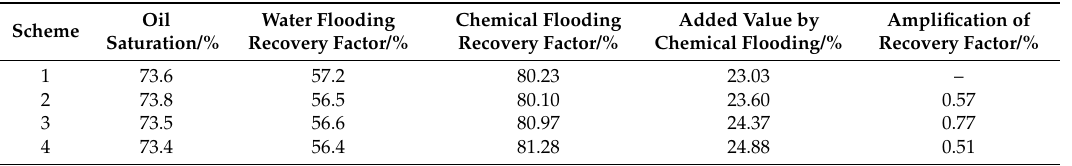
Table 9. Oil displacement results with different surfactant concentrations in the vice